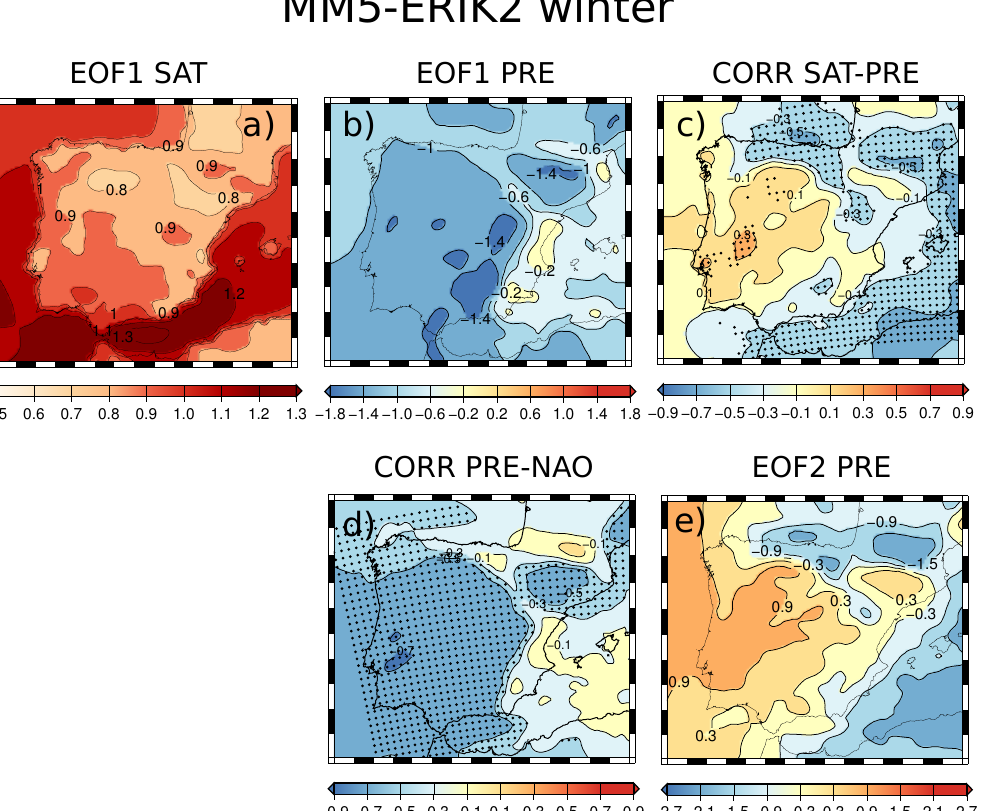
Fig. 7. The three top maps show the first EOF of standardised series of winter SAT (a) and PRE (b) , as well as the correlation between these two variables (c) . (d) shows the correlation between the precipitation series and the NAO index, defined as the PC associated with the leading EOF of SLP in the North Atlantic area. (e) is the second EOF of winter precipitation. All maps are dimensionless and correspond to the MM5-ERIK2 experiment, since the corresponding maps for MM5-ERIK1 are analogous (not shown). The calculations were performed with the smoothed low-frequency series. Black circles denote grid points where the correlation is significant at the 95% confidence level according to a bootstrap method (Ebisuzaki,